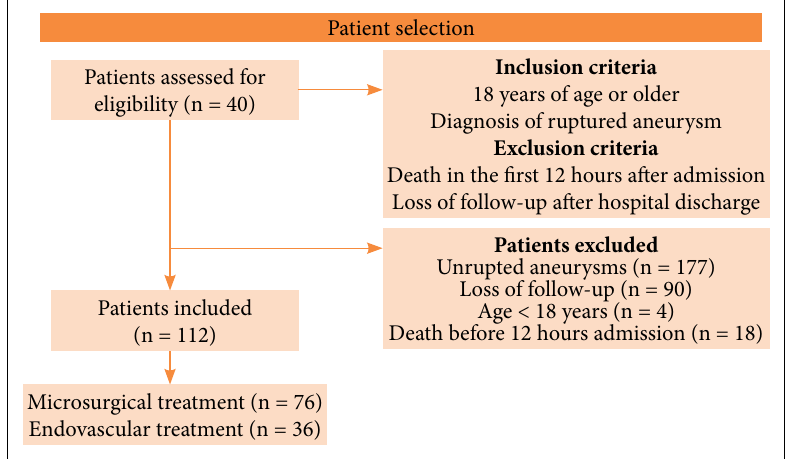
Figure 1 - Flowchart of patient selection.